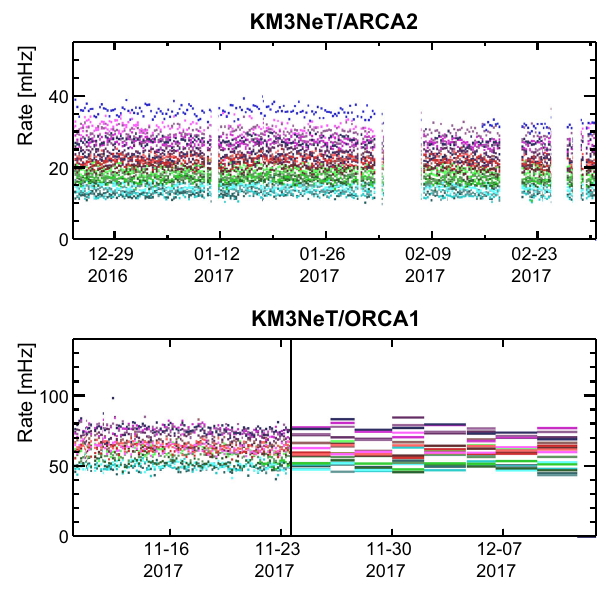
Fig. 6 Rate of multiplicity ≥ 8 coincidences as a function of time for the DOMs of the ARCA2 and ORCA1 detectors. Each point cor- responds to one run and every colour to a single DOM. Vertical white bands are periods without data-taking. The vertical black line in the bot- tom plot represents the date at which the L1 data stream is downscaled (see Sect.